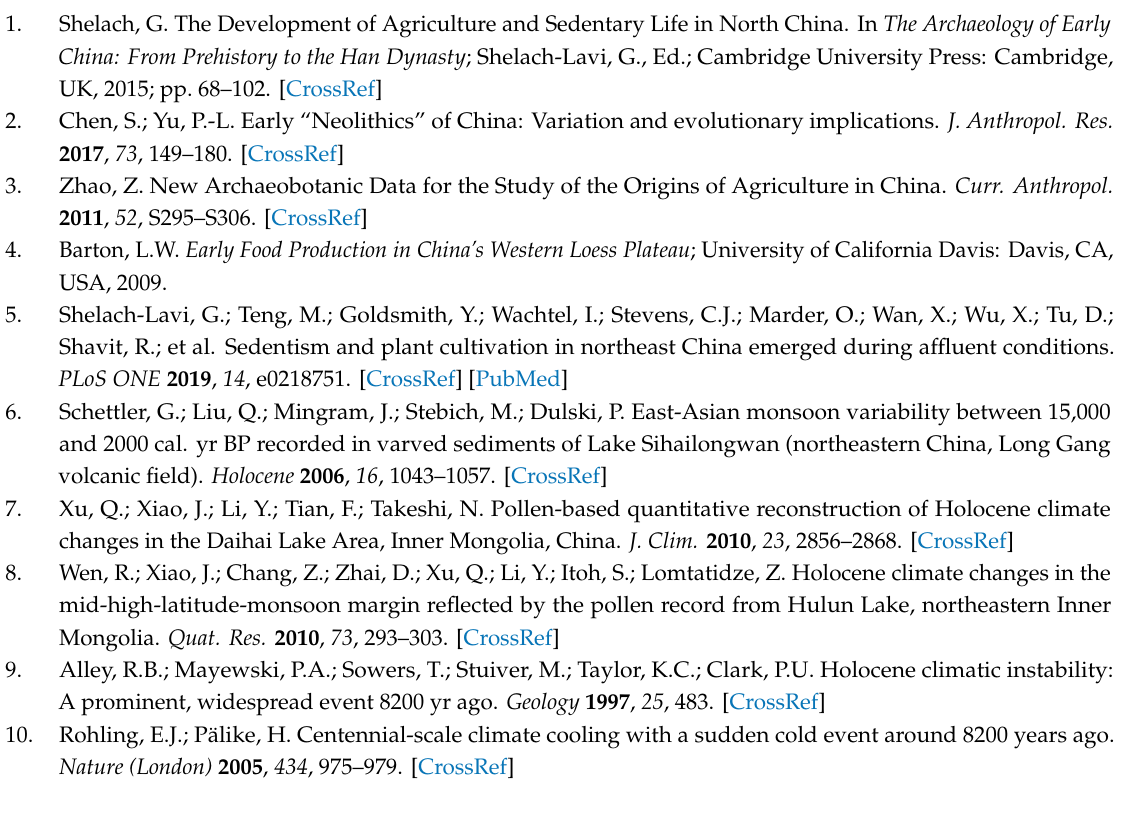
Table S1: The radiocarbon dates of the sites used for constructing the cumulative probability model of Figure 2 in the